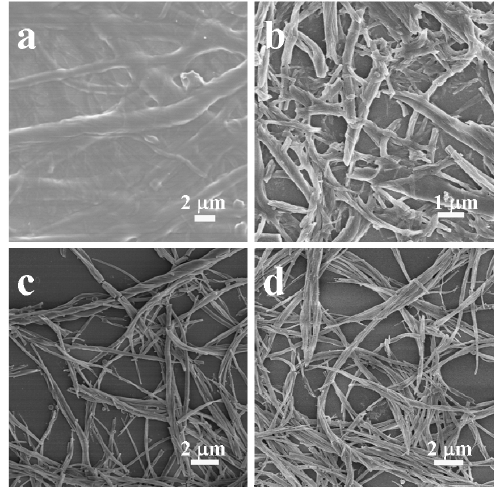
Figure 4. FE-SEM images of the reaction mixture taken at different reaction times: ( a ) before the addition of formaldehyde; ( b ) 5 min after the addition of formaldehyde; ( c ) 10 min after the addition of formaldehyde; ( d ) 30 min after the addition of formaldehyde.